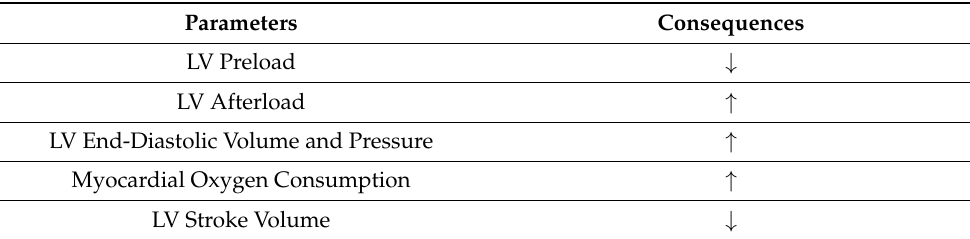
Table 1. Summary of hemodynamic effects of veno-arterial extracorporeal membrane oxygenation (VA-ECMO) leading to left ventricular (LV)